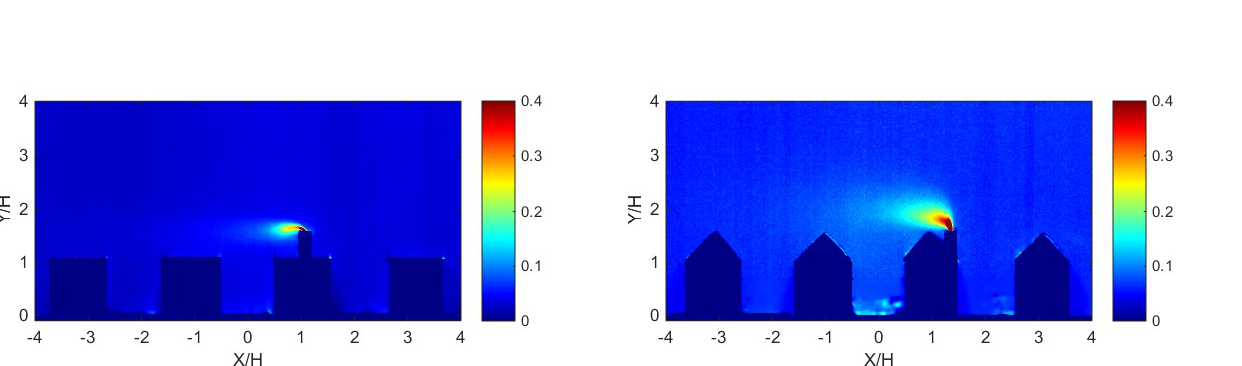
Fig. 10. Mean non- dimensional concentration C/C 0 field (C 0 is the mean concentration measured at the top of the chimneystack) for flat roof and a chimneystack (on the middle of the roof) with h/H = 0.50; the flow moves from the right to the left.